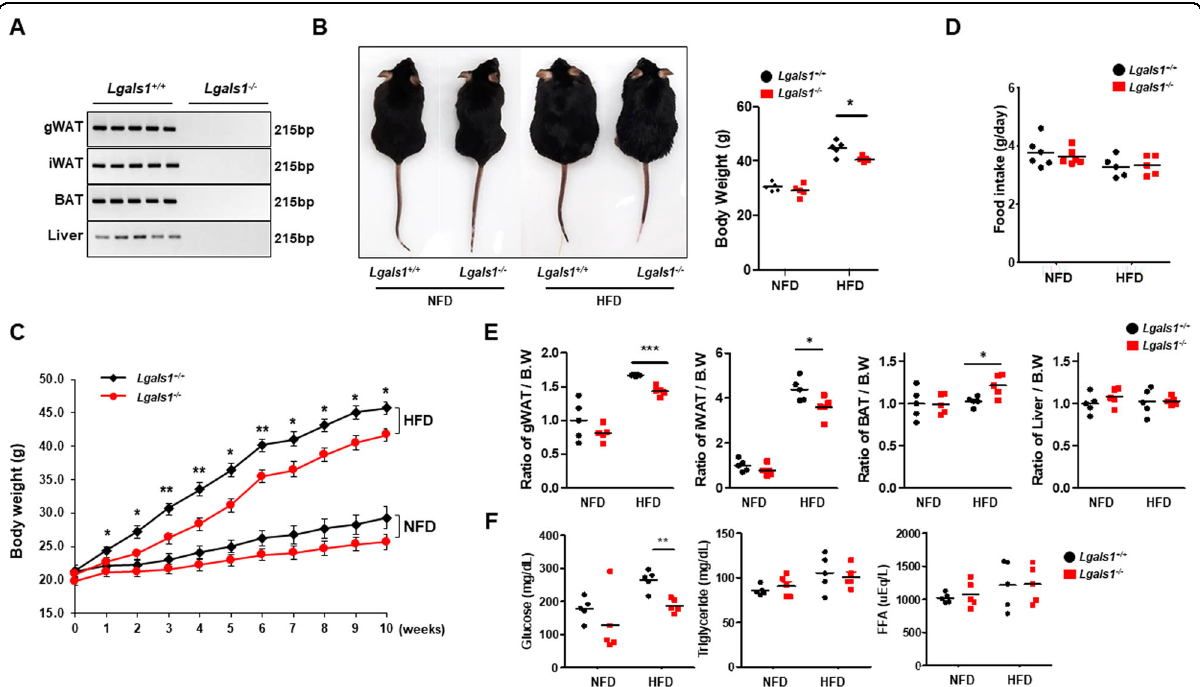
Fig. 4 Lgals1 − / − mice were lean and showed reduced WAT masses. Both Lgals1 + / + and Lgals1 − / − mice were fed a normal-fat diet (NFD) or a high-fat diet (HFD) (60% fat) for 10 weeks ( n = 5 per group). a Expression of galectin-1 mRNA was analyzed by RT-PCR in gonadal white adipose tissue (gWAT), inguinal white adipose tissue (iWAT), brown adipose tissue (BAT), and liver samples from a NFD fed Lgals1 + / + and Lgals1 − / − mice. b Body sizes and weights were measured and presented as a picture and a body weight graph. c The increment of body weight for 10 weeks was presented as a graph. d Daily food intake of Lgals1 + / + and Lgals1 − / − mice fed a NFD or a HFD. e Ratio of gWAT, iWAT, and BAT weights to body weights of Lgals1 + / + and Lgals1 − / − mice fed a NFD or a HFD. f Levels of serum glucose, triglycerides, and free fatty acids in Lgals1 + / + and Lgals1 − / − mice fed a NFD or a HFD. Data are presented as the mean ± SEM * p < 0.05, ** p < 0.01, and *** p < 0.001 for the Lgals1 + / + mice vs. the Lgals1 − / −